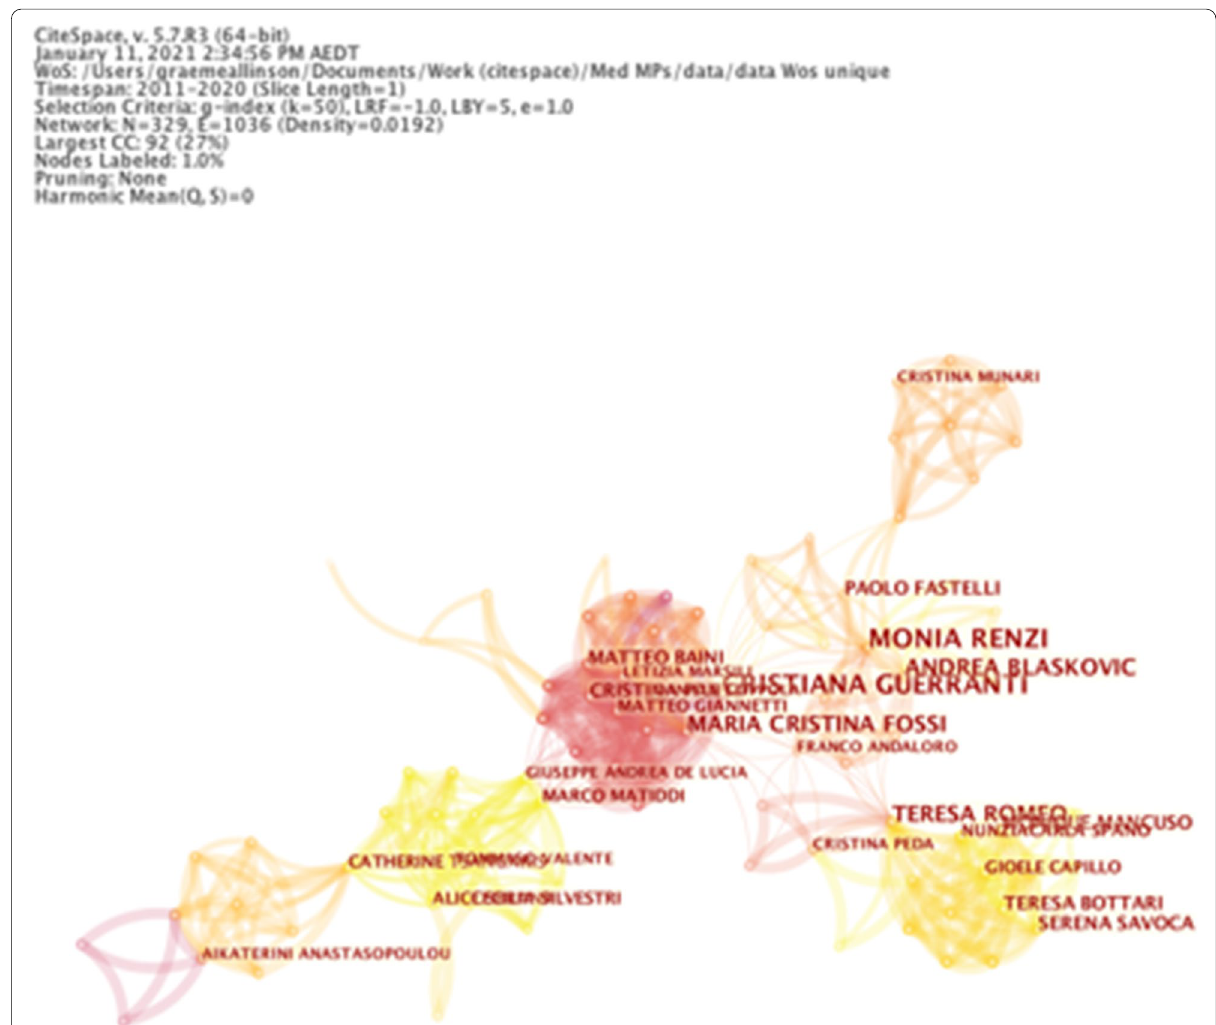
Fig. 4 Author co-authorship network, where each node represents an author, modified to show only main network (see Fig. S2 for complete network; modularity Q 0.4281, average silhouette 0.9354). Link colour signifies the earliest period that the link was established (purple, oldest; = = yellow, most recent). Nodes without labels were below the threshold ( n =